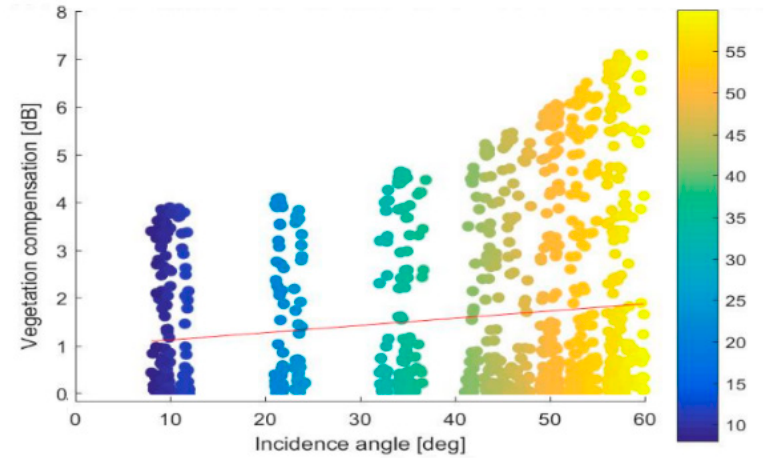
Figure 15. Vegetation compensation [dB] (Equation (1)) for di ff erent incidence angles.